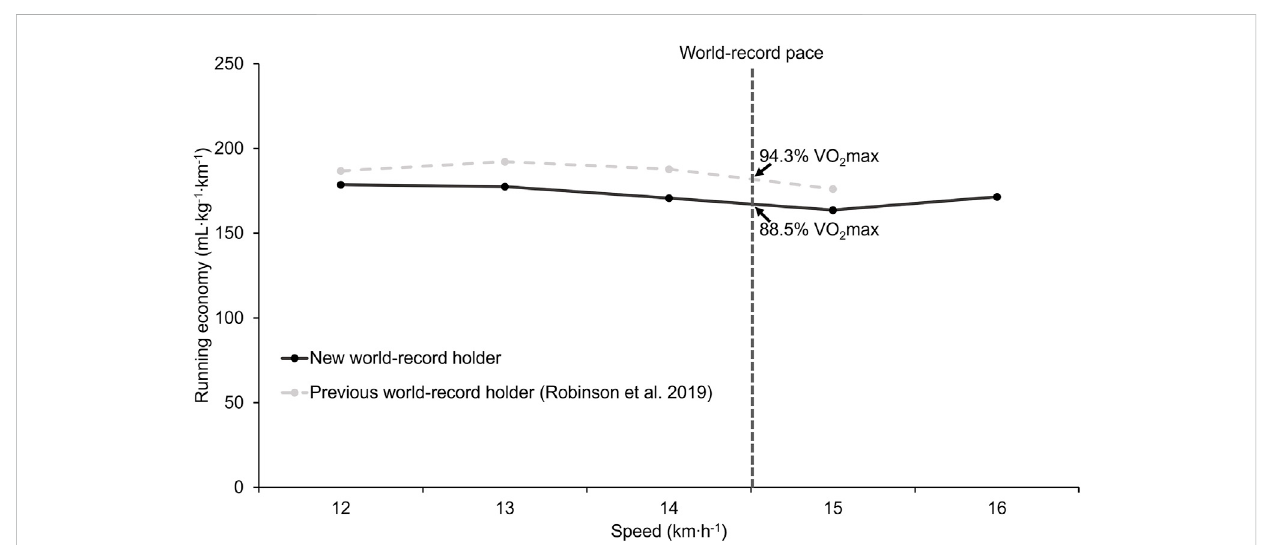
FIGURE 2 Oxygen uptake at different running speeds for the new and previous world record holders. Data from the previous world-record holder were obtained from Robinson et al. (Robinson et al., 2019) using WebPlotDigitizer. The vertical dashed line represents the world-record running speed of 14.52 km h − 1